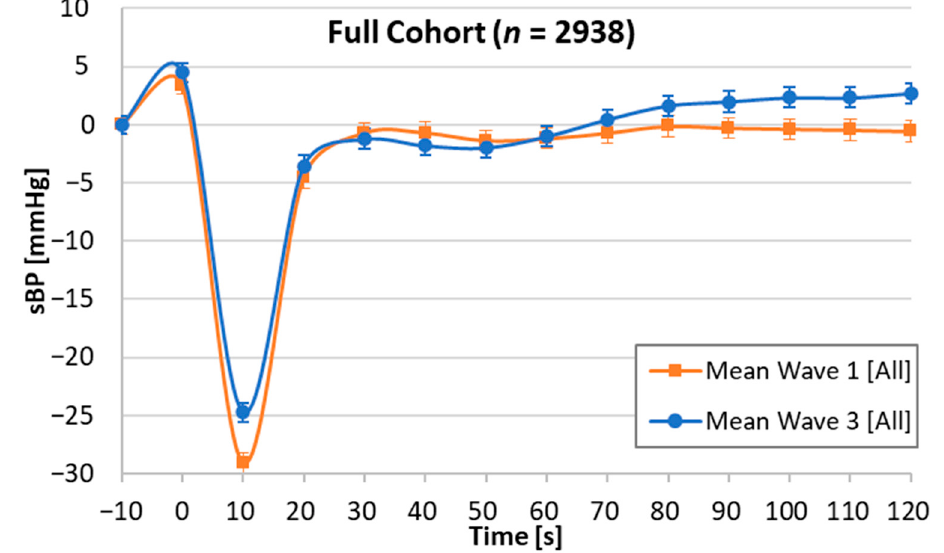
Figure 1. Graphical visualisation of the orthostatic systolic blood pressure active stand profiles of the full cohort at Wave 1 and Wave 3. SBP: systolic blood pressure.